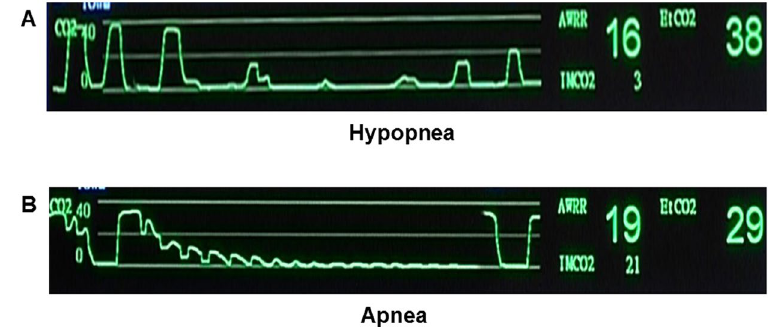
Figure 1. Hypoventilation waveform demonstrated by capnography. ( A ) Hypopnea: successive two breaths of at least 50% reduction of peak wave comparing to baseline and the peak of the secondary wave should be lower than the first wave. ( B ) Apnea: no wave for 10